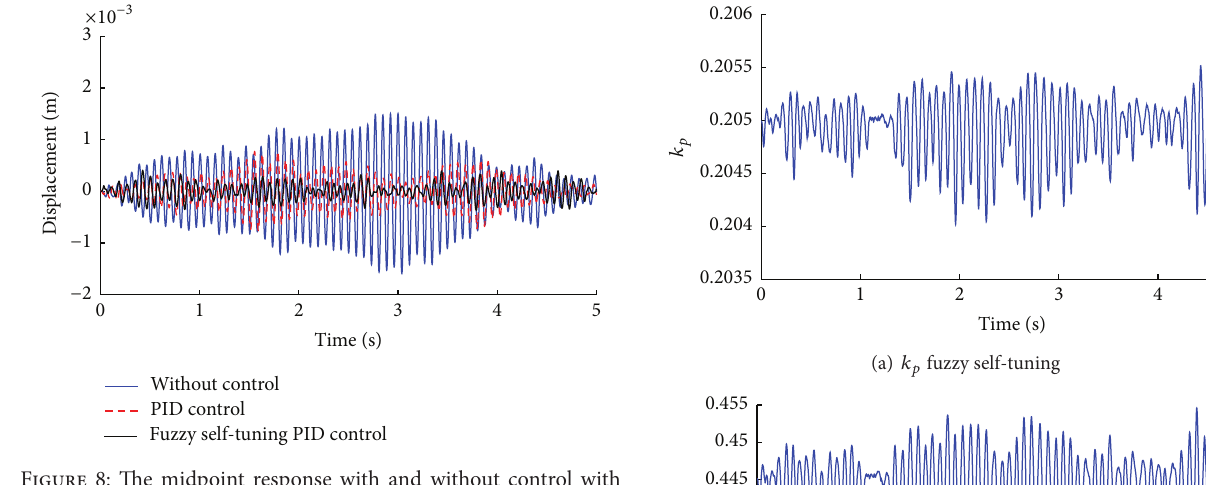
Figure 8: The midpoint response with and without control with white noise disturbance.